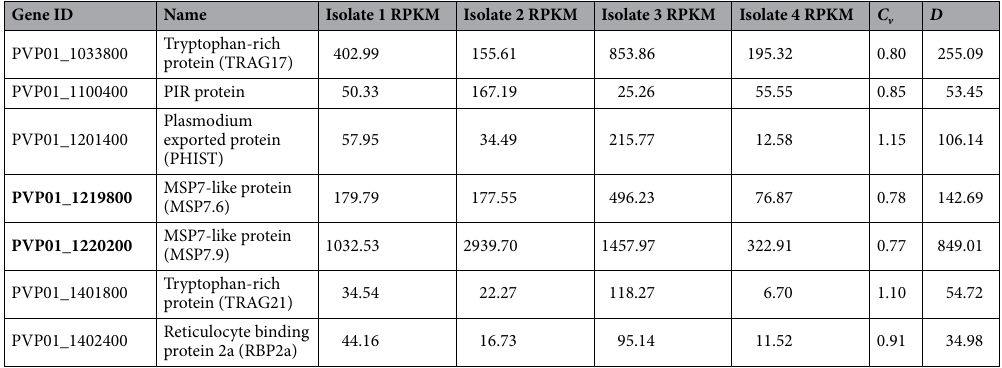
Table 2. Differentially expressed genes belonging to clusters (in bold) or multigene families in Cambodian isolates (RPKM-adjusted for sequence variation).